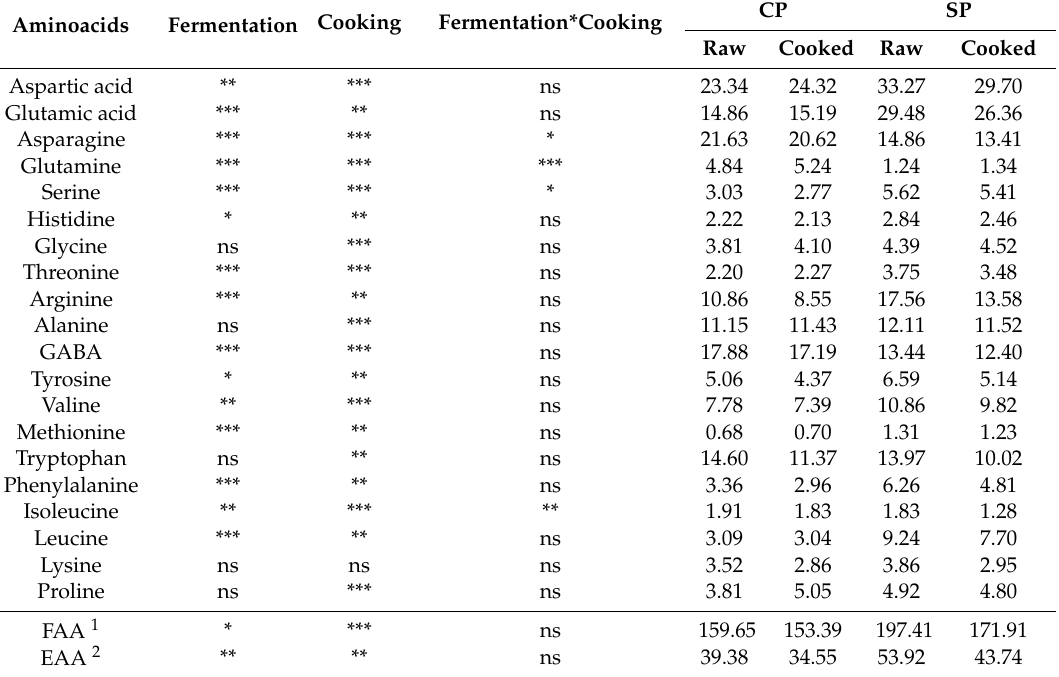
Table 3. Free amino acid content in pasta samples (mg / 100 g of pasta dry